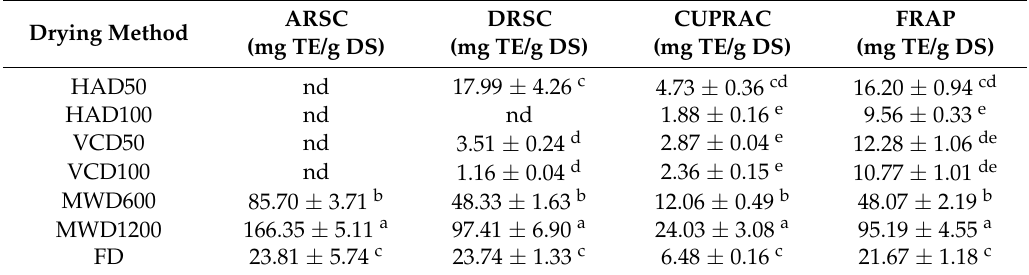
Table 4. Correlations between phytochemical compounds and antioxidant activity of carrot peel dried at various conditions. Correlations * (R 2 ) ARSC DRSC